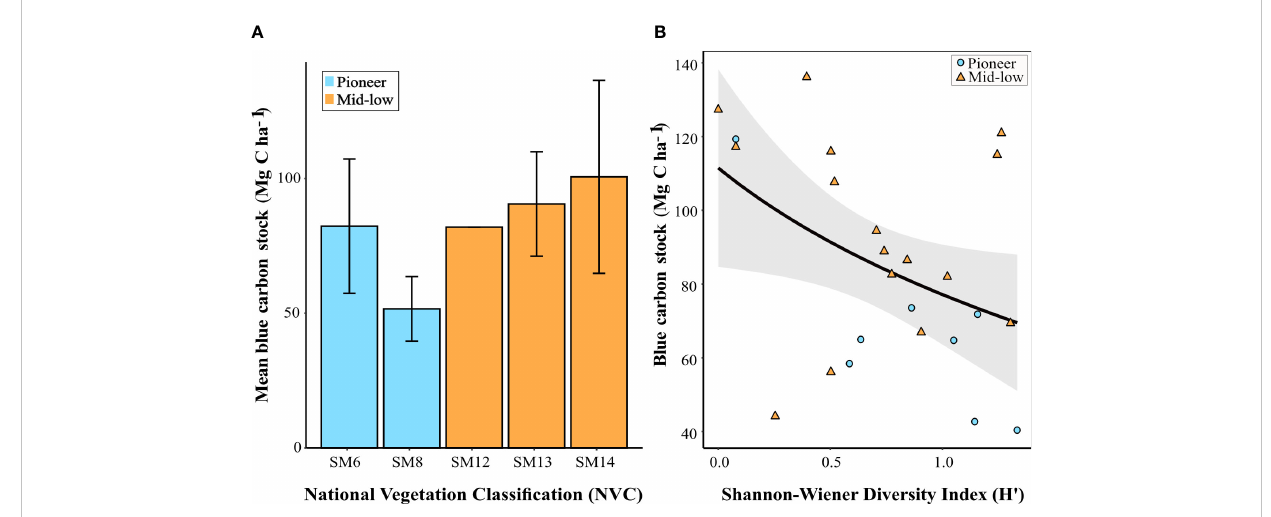
FIGURE 5 (A) Mean carbon stock ± standard deviation for each dominant National Vegetation Classi fi cation (NVC) community found in the managed realigned sites at Northey Island and Orplands (pioneer communities = blue; mid-low communities = orange). Number of observations varied across NVC groupings: SM6 (n = 4), SM8 (n = 4), SM12 (n = 1), SM13 (n = 8), and SM14 (n = 7). See Supplementary Table 1 for NVC categories and corresponding marsh zone; and (B) Carbon stock against Shannon-Wiener Diversity Index for Northey Island and Orplands managed realigned sites, with